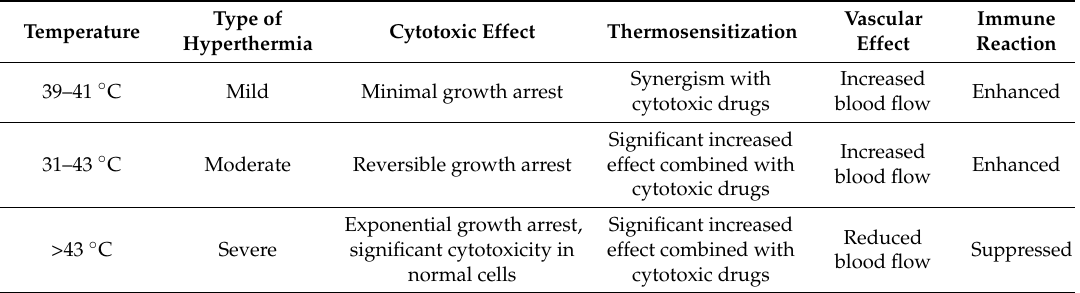
Table 3. Temperatures used for